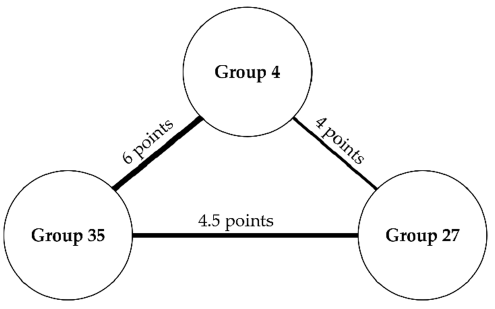
Figure 5. Diagram of groups’ experiences and strength of relationships.